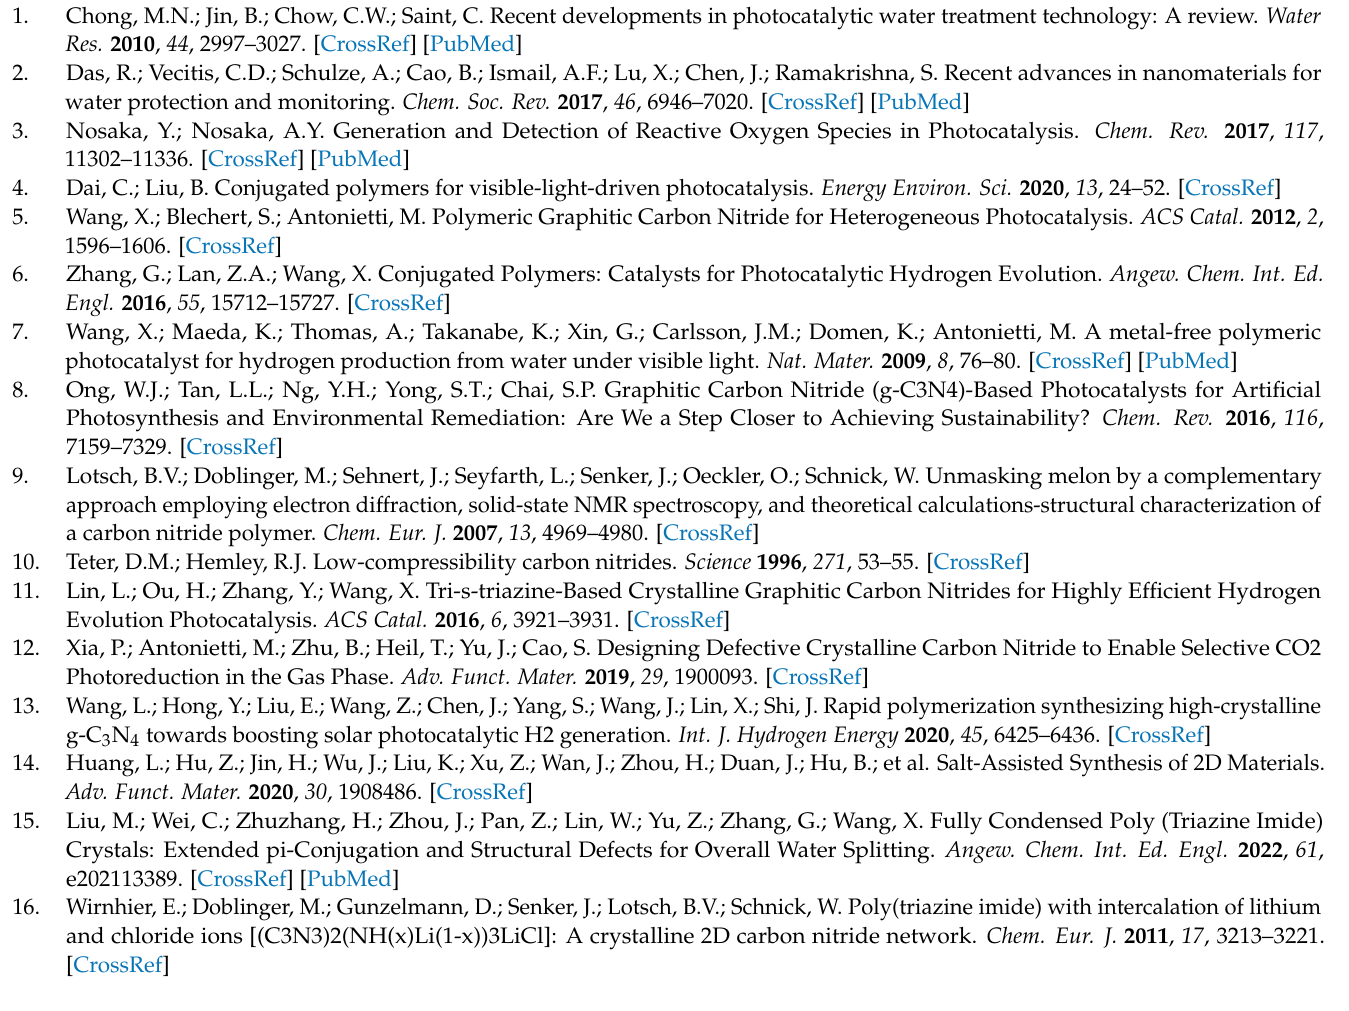
phenol, and RhB; Figure S7: Adsorption-desorption tests of photocatalyst-pollutants solution in dark; Figure S8: Rate constants for the photocatalytic degradation of (a): TC, (b): phenol and (c): RhB; Figure S9: Stability tests of PHI photocatalyst for the degradation of TC. (a–c): XRD patterns, FTIR spectra and K-2p spectra before and after the reaction. (d): Cyclic tests; Figure S10: Emission spectrum of PLS-SXE 300D Xe lamp equipped with AM1.5 G filter. (Obtained from Perfectlight Sci&Tech, China); Figure S11 UV-vis absorption spectra of pure water, RhB solution (10 mg · L − 1 ), phenol solution (10 mg · L − 1 , after colorimetric reaction) as well as photocatalyst solution before and after filtration